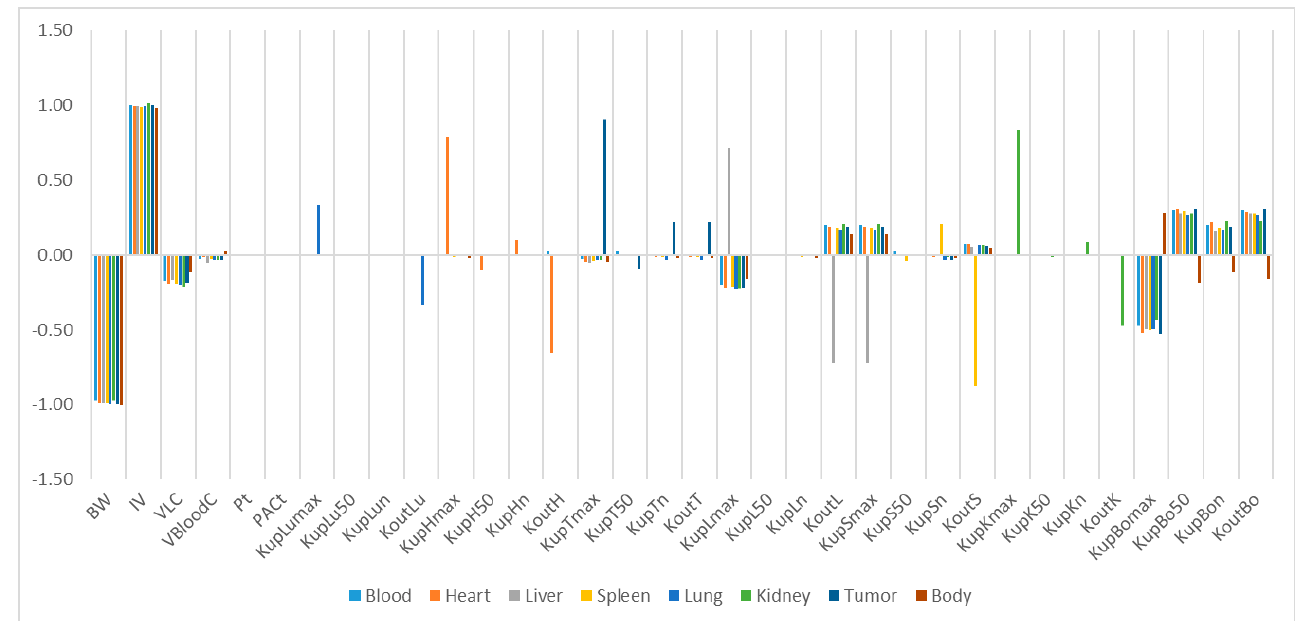
Figure 10. Relative sensitivity analyses for the parameters of mPEG5k-28.57%-200 nm NPs.